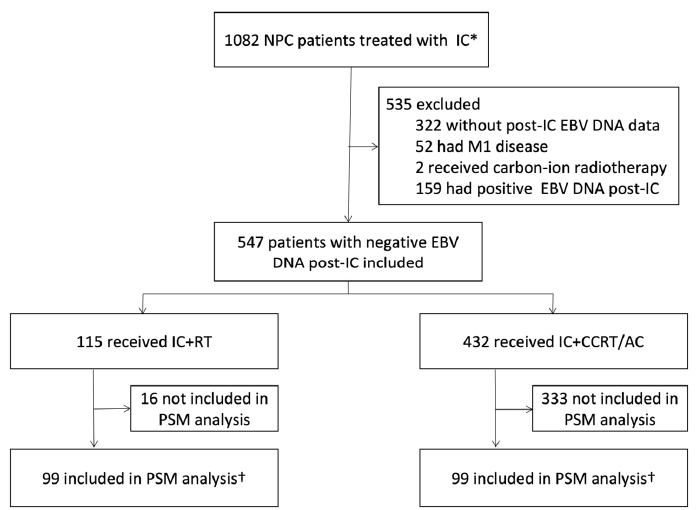
Figure 1. Flow Diagram of Enrollment. * Started receiving induction chemotherapy (IC) between September 2017 and November 2020. † Propensity score matching by gender, age, T category, N category, clinical stage, pre-IC EBV DNA levels, IC regimen, IC cycle, and targeted therapy. Abbreviations: NPC, nasopharyngeal carcinoma; IC, induction chemotherapy; EBV DNA, Epstein- Barr virus (EBV) DNA; RT, radiotherapy; CCRT, concurrent chemoradiotherapy; AC, adjuvant chemotherapy; PSM, propensity score